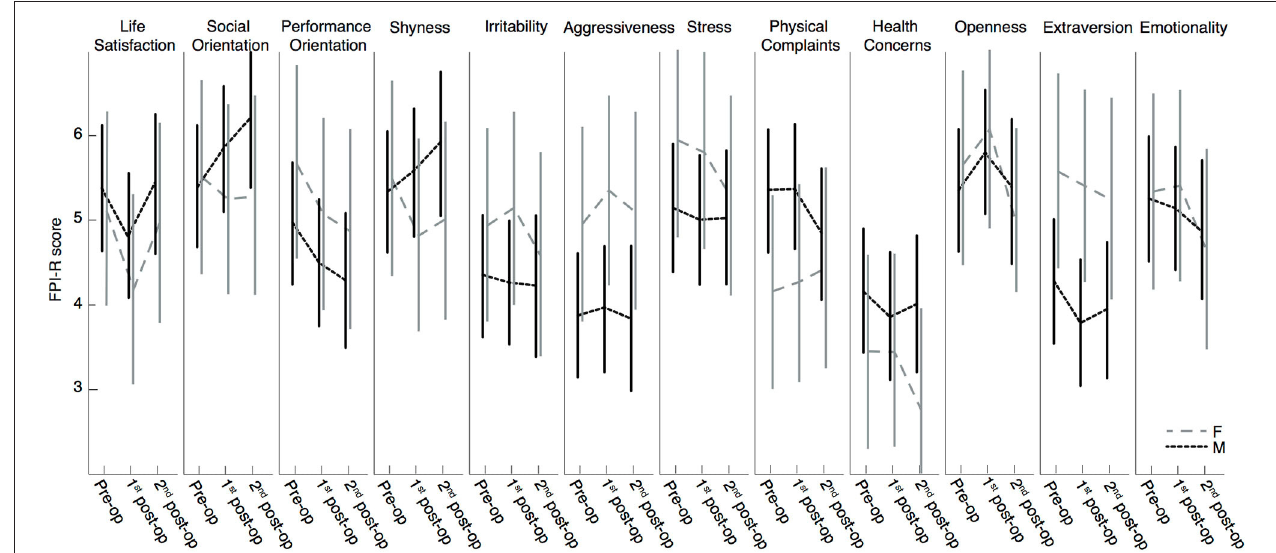
FIGURE 1 | Estimated marginal means of FPI-R scores with 95% CI. Assessment of 10 subscales and two additional scales (Extraversion and Emotionality) to analyze the effect of DBS on the personality of the patient: pre-operation, 1st post-operation, 2nd post-operation separated by sex: F = female, M = male. High stanine values (from 1 to 9) indicate a strong expression of this personality trait.